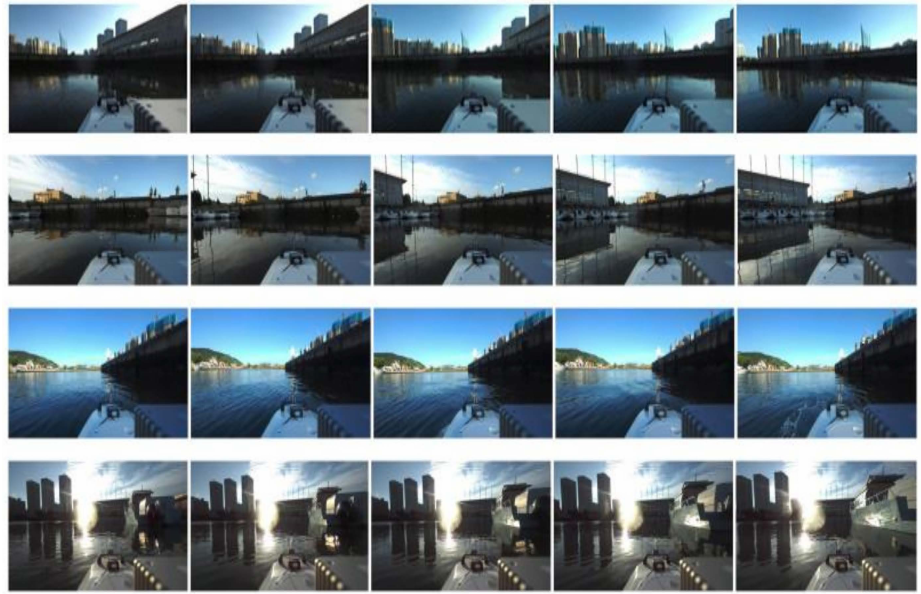
Figure 9. Image data corresponding to point cloud.